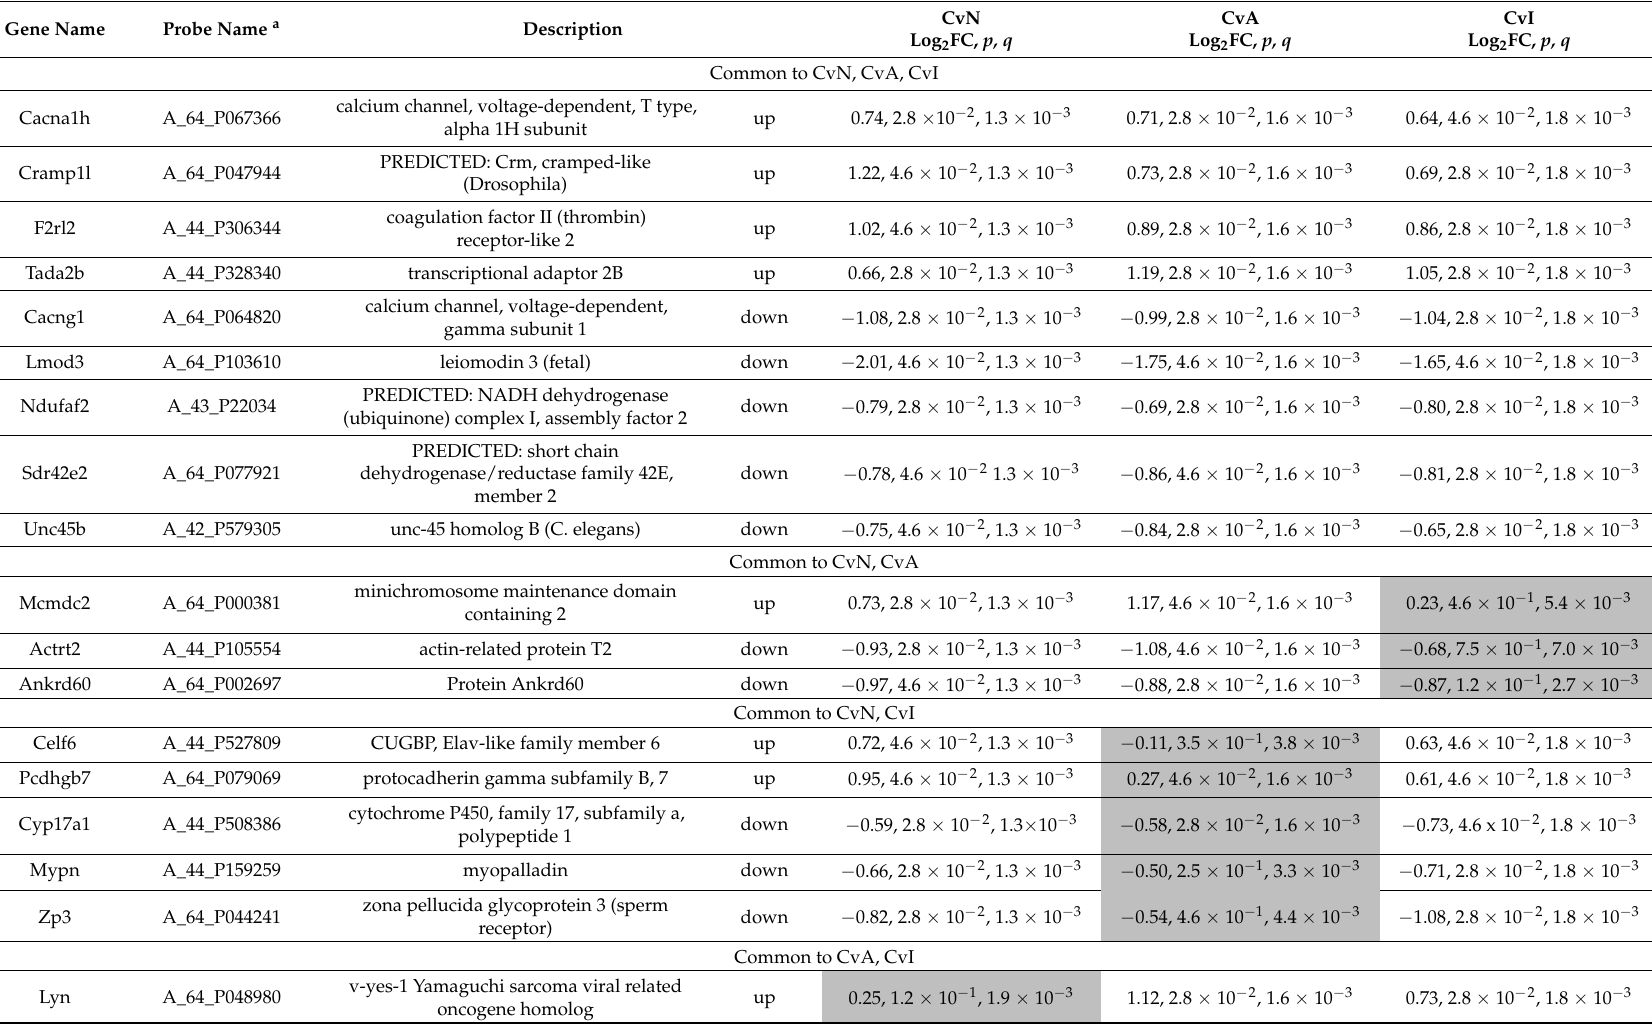
Table 1. DE genes common to two or three pairs of CvN, CvA, and